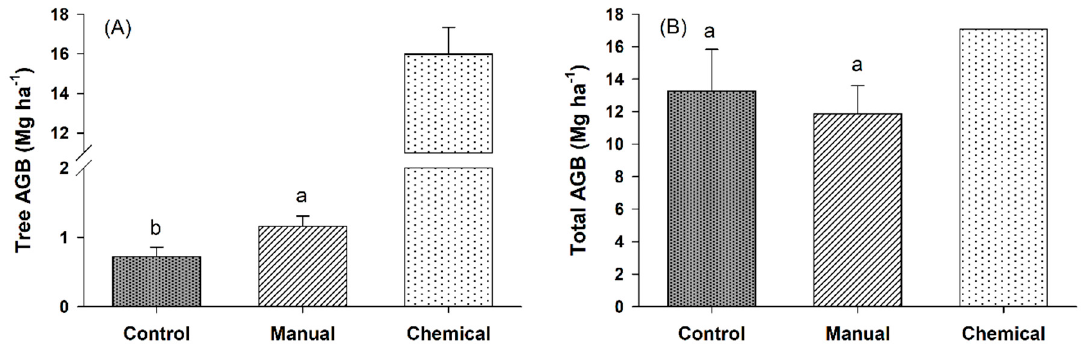
Figure 6. Means and standard errors of ( A ) tree aboveground biomass and ( B ) total aboveground biomass (i.e., trees and shrubs) on a twelve-year-old ponderosa pine plantation grown in no release control, manual release, and chemical release treatments. Different letters (a, b) refer to a significant difference between the two treatments ( p < 0.05). Chemical release was not in the analysis because it was not in the original design.